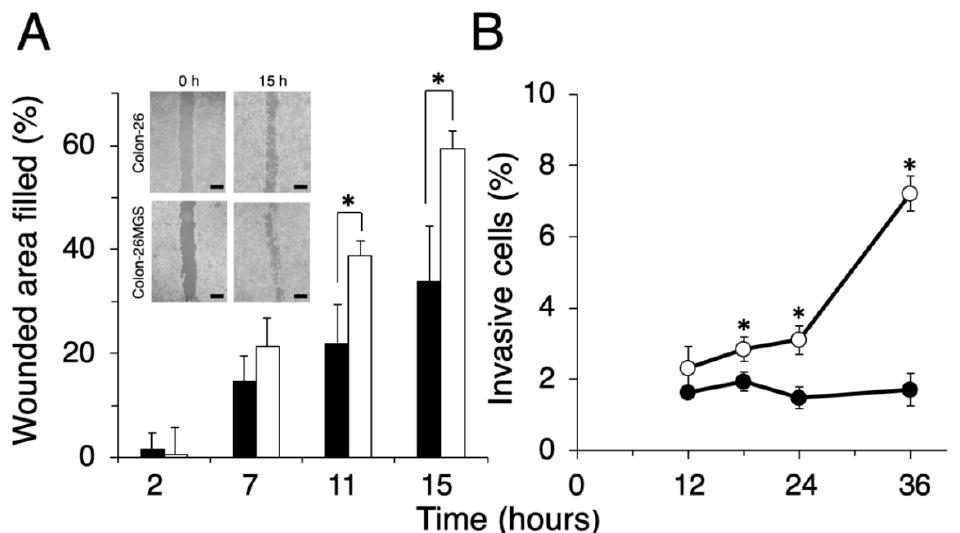
Figure 2. Comparison of migration and invasion ability between Colon-26MGS and Colon-26. ( A ) Filled wounded area of cancer cells (scale bar: 1 mm); ( B ) Invasion ability. Colon-26 (closed symbols), Colon-26MGS (open symbols) *, p < 0.05 by Student’s t -test. Bars indicate standard error calculated using data from three independent trials.